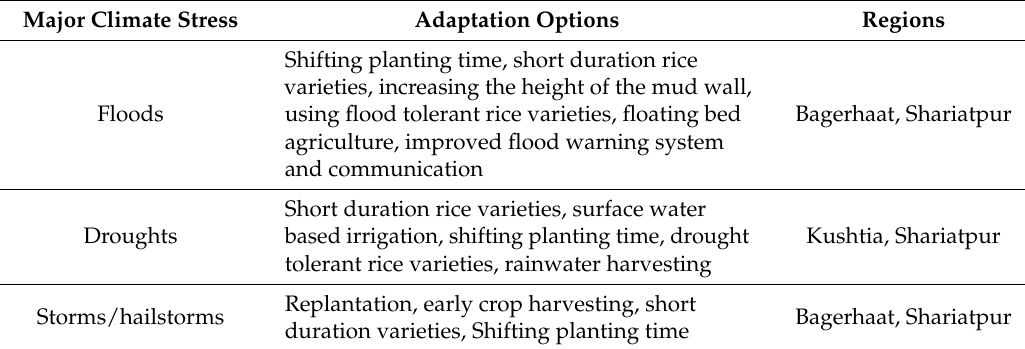
Table 2. Existing adaptation practices in the agriculture sector across